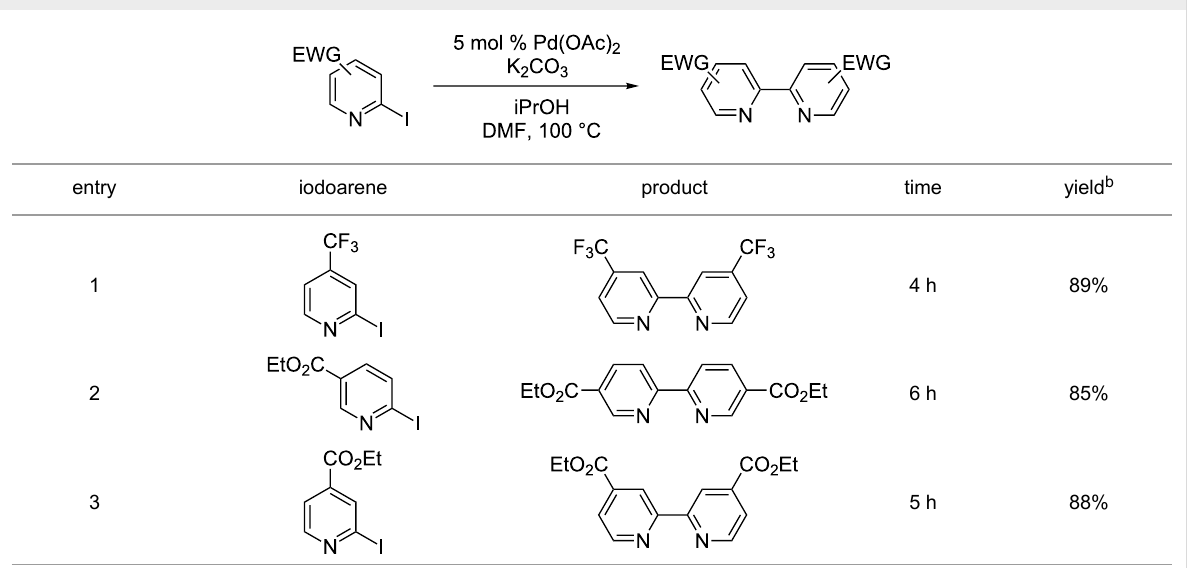
Table 2: Pd-Catalyzed synthesis of other ligands used to support electron-deficient Ru(II) chromophores. a